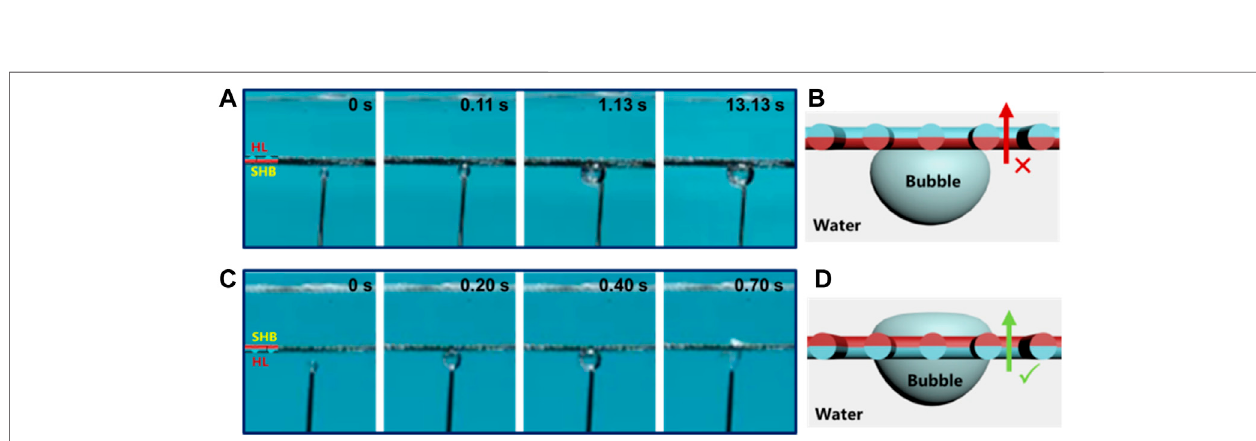
FIGURE 2 | The surface morphology and wettability of a single-layer Janus CM. (A,B) SEM images of the upper SHB side of the Janus CM. (D,E) SEM images of the lower HL side of the Janus CM. Contact angle images of the SHB side (C) and the HL (F) of the Janus CM in air, respectively.